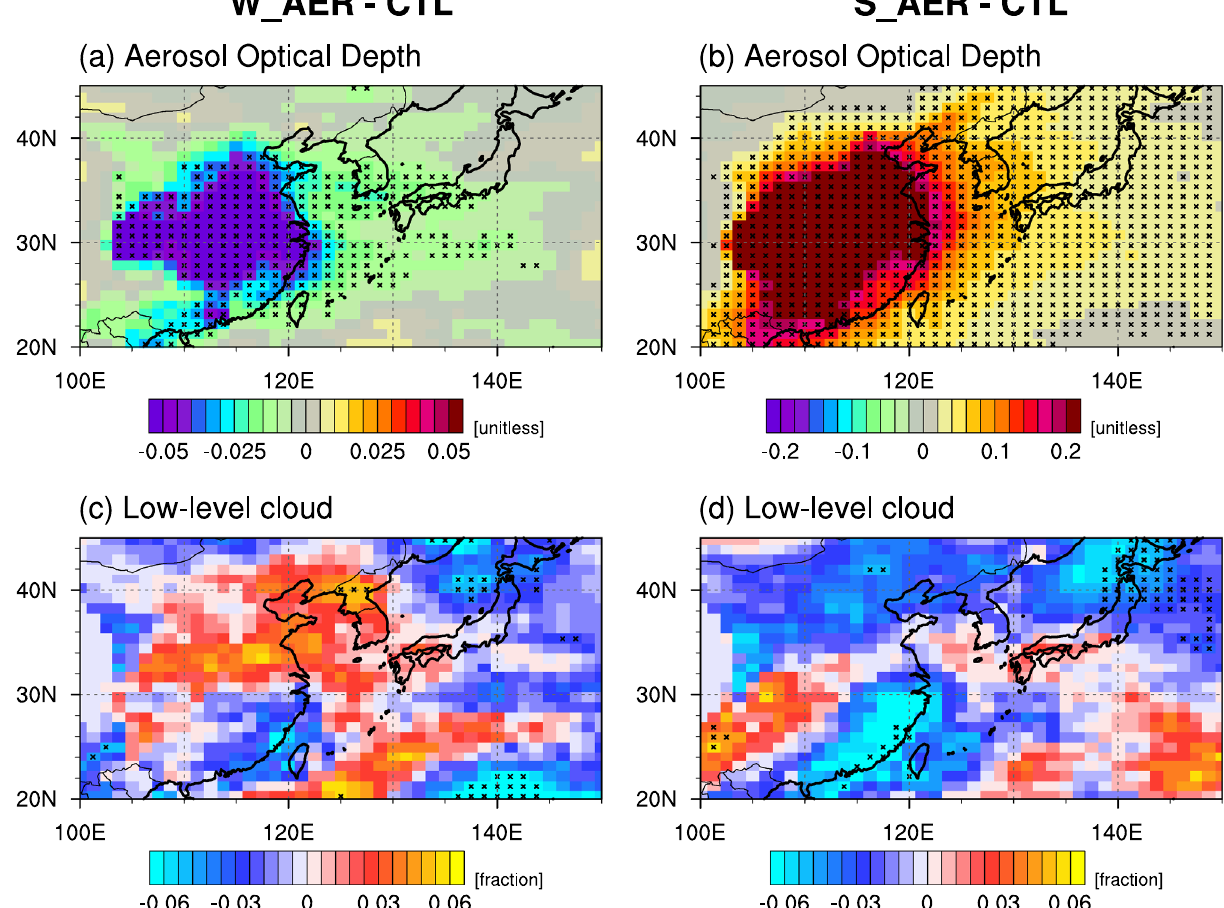
Figure 2. Difference fields in February between W_AER and CTL (left panels) and between S_AER and CTL (right panels). ( a , b ) Aerosol optical depth and ( c , d ) low-level cloud. Black crosses represent grid points where the composite mean difference is significant above the 90% confidence level. The figure was generated using NCAR Command Language Version 6.5.0 (http:// dx. doi. org/ 10. 5065/ D6WD3 (Fig. 1e,f). In the composite difference between the COVID-19 lockdown phase in February 2020 and previous years (2016–2019), we find a decrease in cloud base height and an increase in low-level cloud cover over China, although the strongest anomalies occured in northeastern China (Fig. 1b,c). Differences in the cloud patterns between the COVID-19 case and the Chinese New Year holidays can be partly explained by the fact that the Chi- nese New Year holiday composite is based on a 10-year average, which reduces noise due to synoptic transients more effectively than for the single-realization of COVID-19 lockdown composite. Whether the climatic anomalies that occurred in February 2020 over parts of East Asia, which included, among others, a decrease of the cloud base height by up to 2 km and an increase of low-level cloud cover by 0.1–0.2 over industrialized northeastern China and parts of the Korean Peninsula can be directly linked to the imposed reduction of air pollution remains an open question. In fact, a potential increase in cloud cover in response to a reduction of anthropogenic aerosols would seem counter-intuitive to our understanding of the hygroscopic properties of aerosols serving as cloud condensation nuclei (CCN). Reduced anthropogenic aerosols and cloud changes. To better understand the robustness of the observational results (Fig. 1) and identify the underlying mechanism of increased low-level cloud cover during times of reduced anthropogenic aerosol concentration, we compare simulated low-level clouds in the W_AER with the CTL. As expected from the imposed 40–70% reduction of aerosol loadings in the W_AER we find a substantial decrease in AOD over China (Fig. 2a), which bears qualitative resemblance to the observations (Fig. S1b). As a result, the concentration of CCN decreases substantially by ~ 30%, particularly in the lower troposphere (Fig. S3a). However, similar to the observations, we find a weak increase in low-level cloud cover in northeastern China, which extends across the Korean Peninsula (Fig. 2c). This seemingly counter-intuitive result is also reflected in the vertical profile of cloudiness in W_AER (Fig. S3c), even though the response is quite weak and not statistically significant. Furthermore, consistent with the observations (Fig. 1c), the model also simulates a reduction of low-level clouds over southern China. Again, the amplitude is reduced relative to the observations.